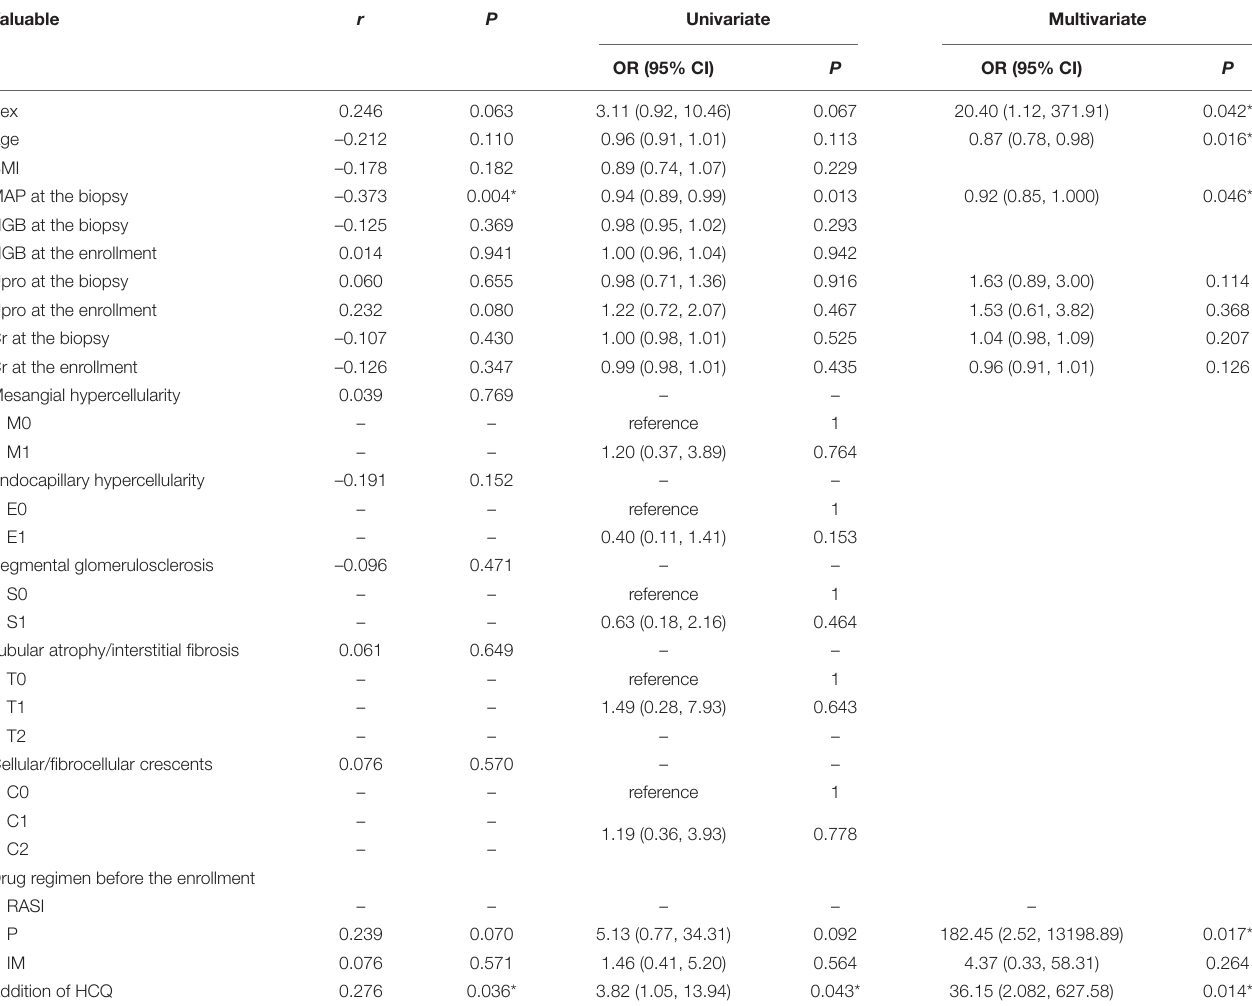
TABLE 6 | Clinicopathological features associated with the effective reduction frequency in residual proteinuria in patients treated with RASI + P ± IM or HCQ + RASI + P ± IM. Valuable r P Univariate Multivariat